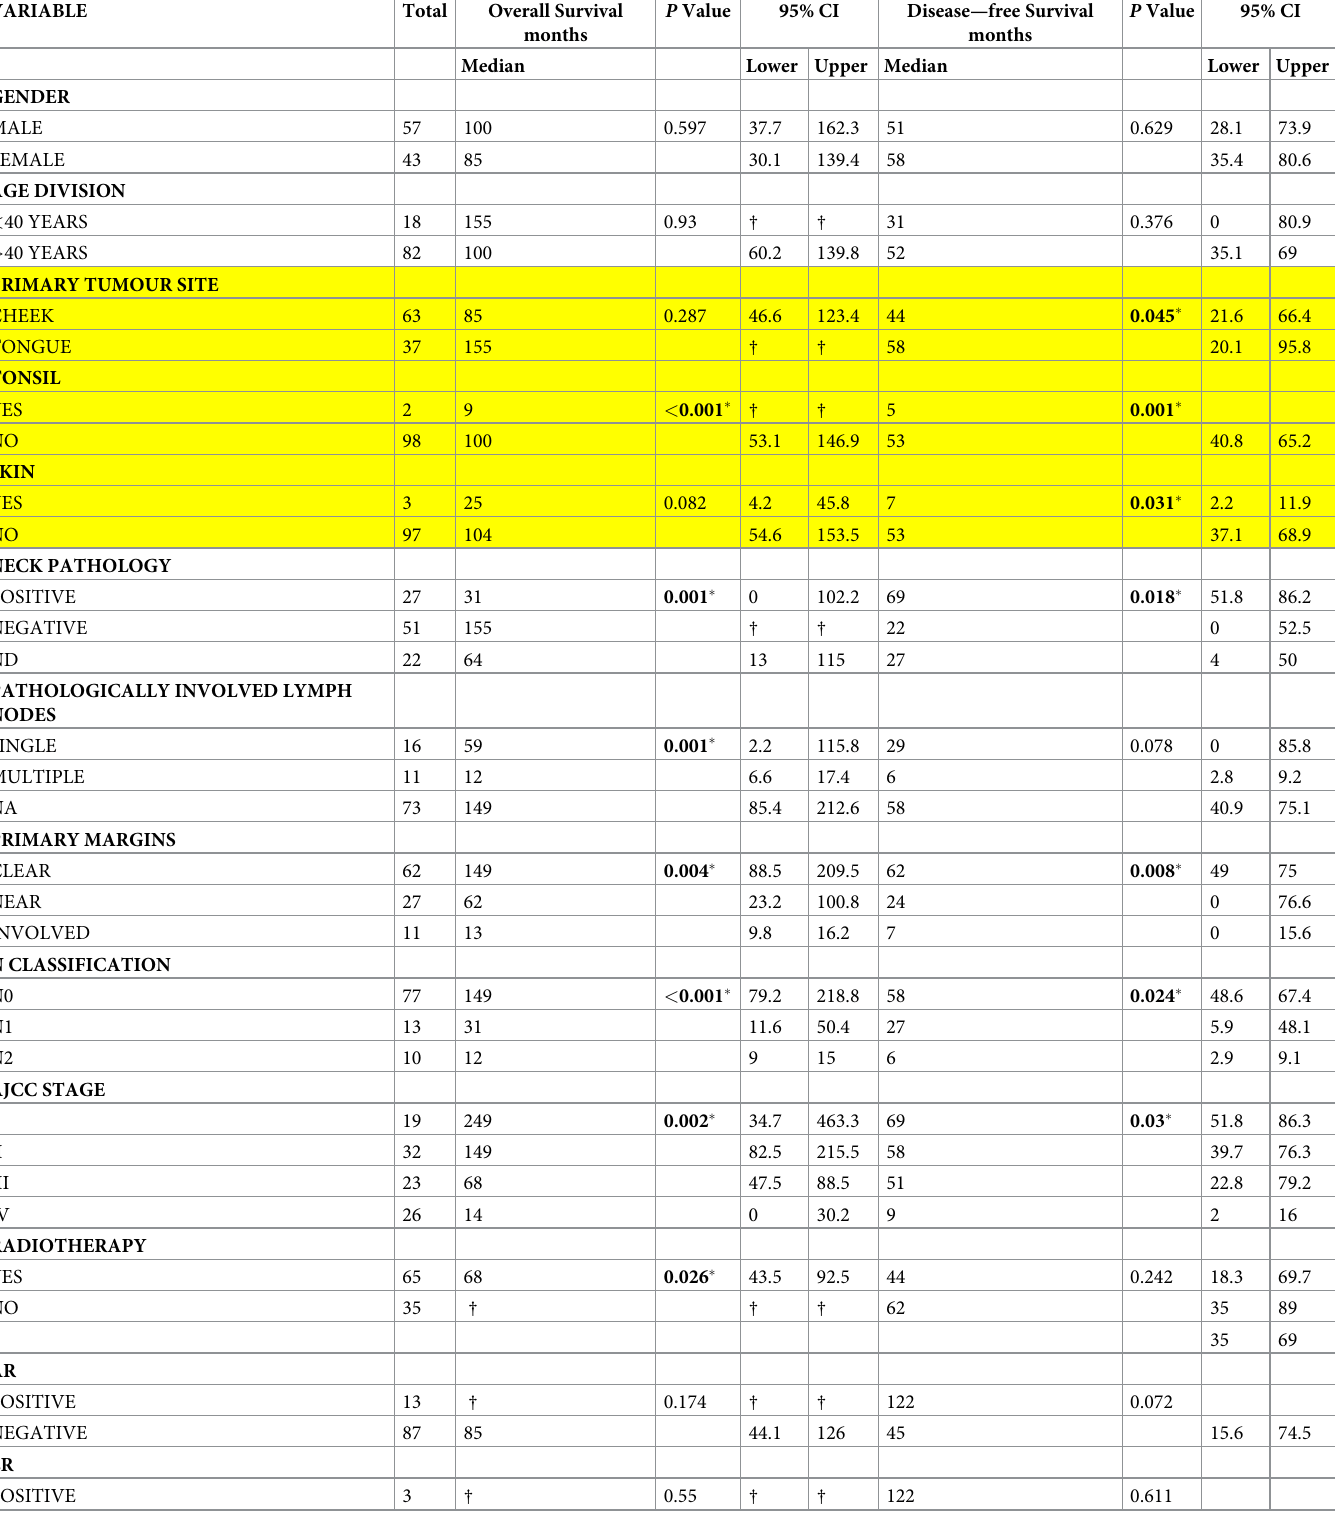
Table 2. Association of clinicopathologic variables and Her-2, AR and ER with overall and disease-free survival.